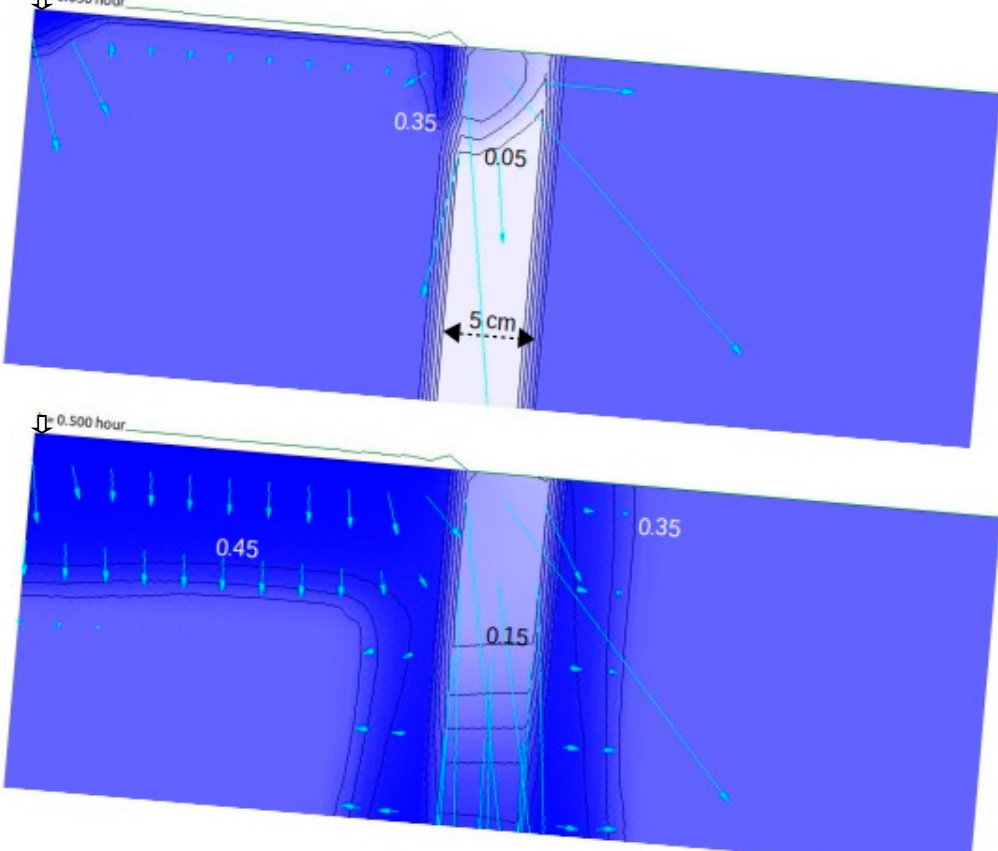
Figure 10. Flow simulation on loamy soil with sand ditch filled with Tottori sand at t = 0.05 h (upper) and t = 0.5 h (lower) after initiation of inflow from the left upper edge at 3 cm/h ( ↆ ).